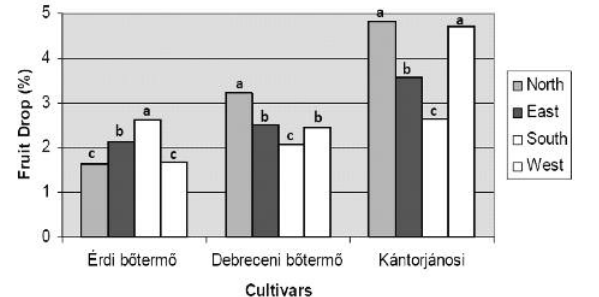
Figure 5A. Fruit drop of sour cherry cultivars on different direction of the tree